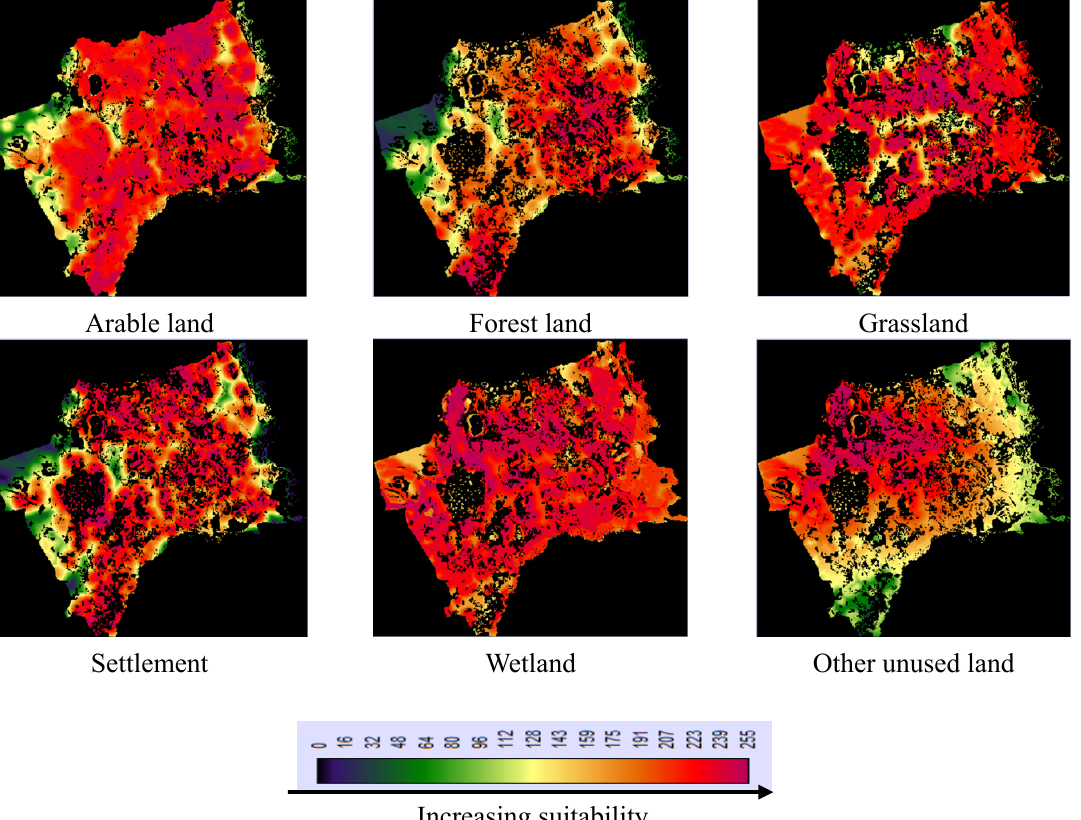
Figure 5. Suitability maps for various land categories.